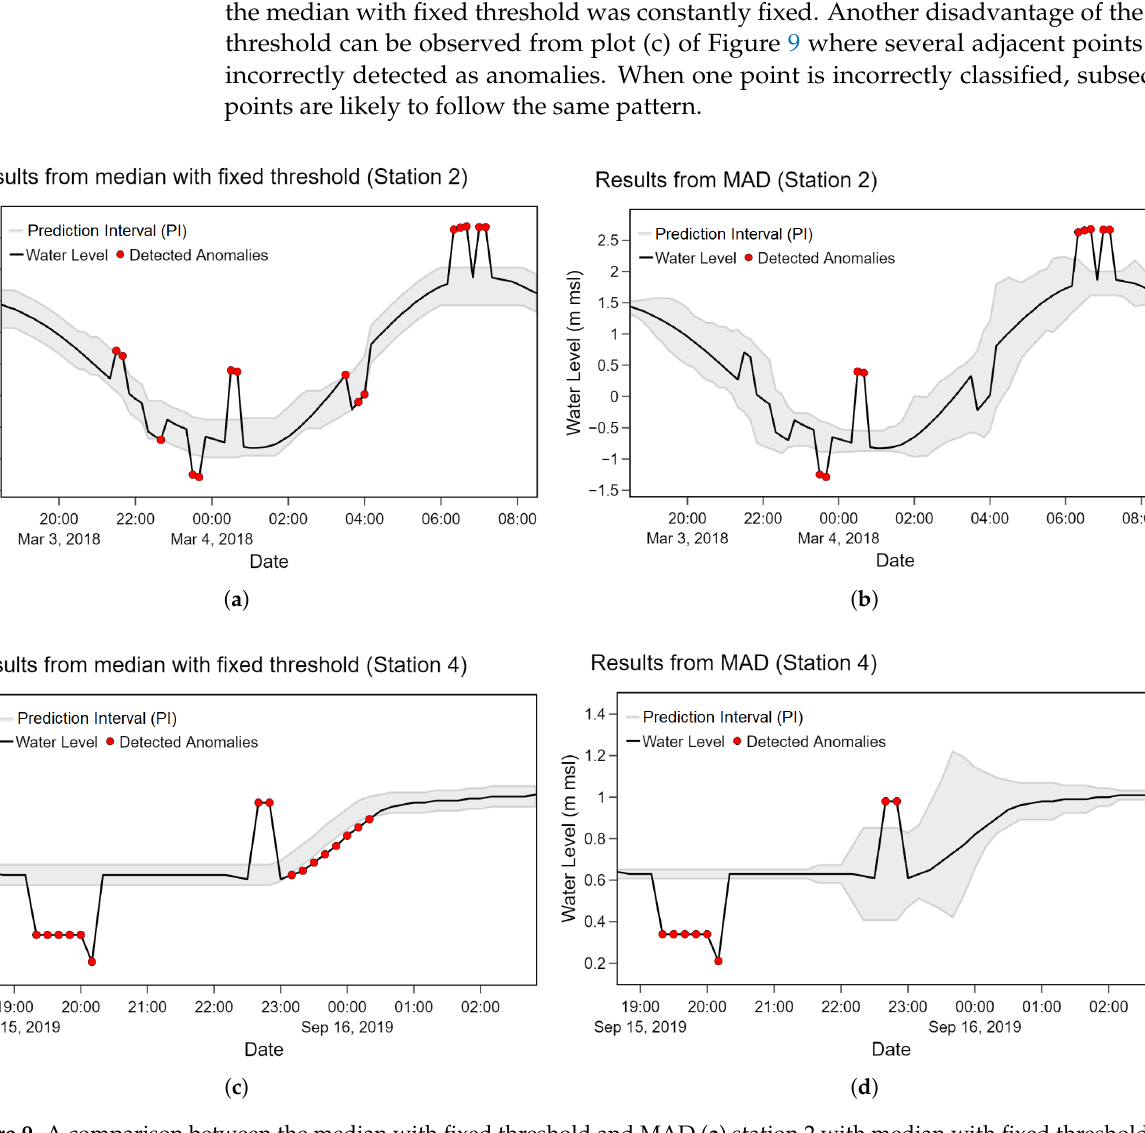
Figure 9. A comparison between the median with fixed threshold and MAD ( a ) station 2 with median with fixed threshold; ( b ) station 2 with MAD. ( c ) station 4 with median with fixed threshold; ( d ) station 4 with